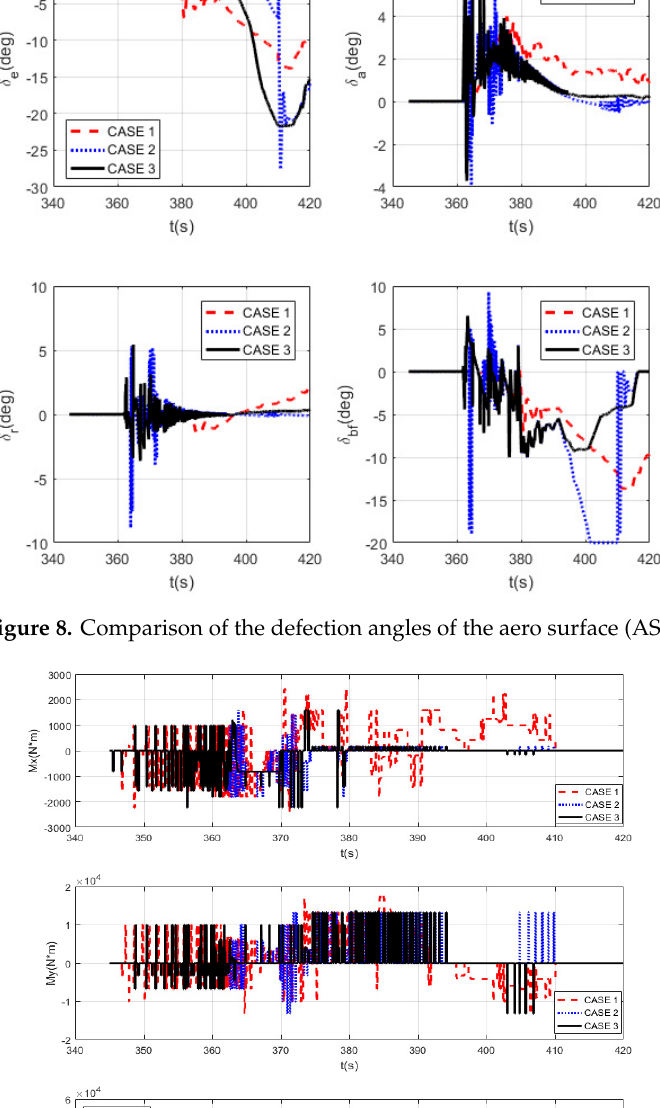
Figure 7. The control errors comparison.